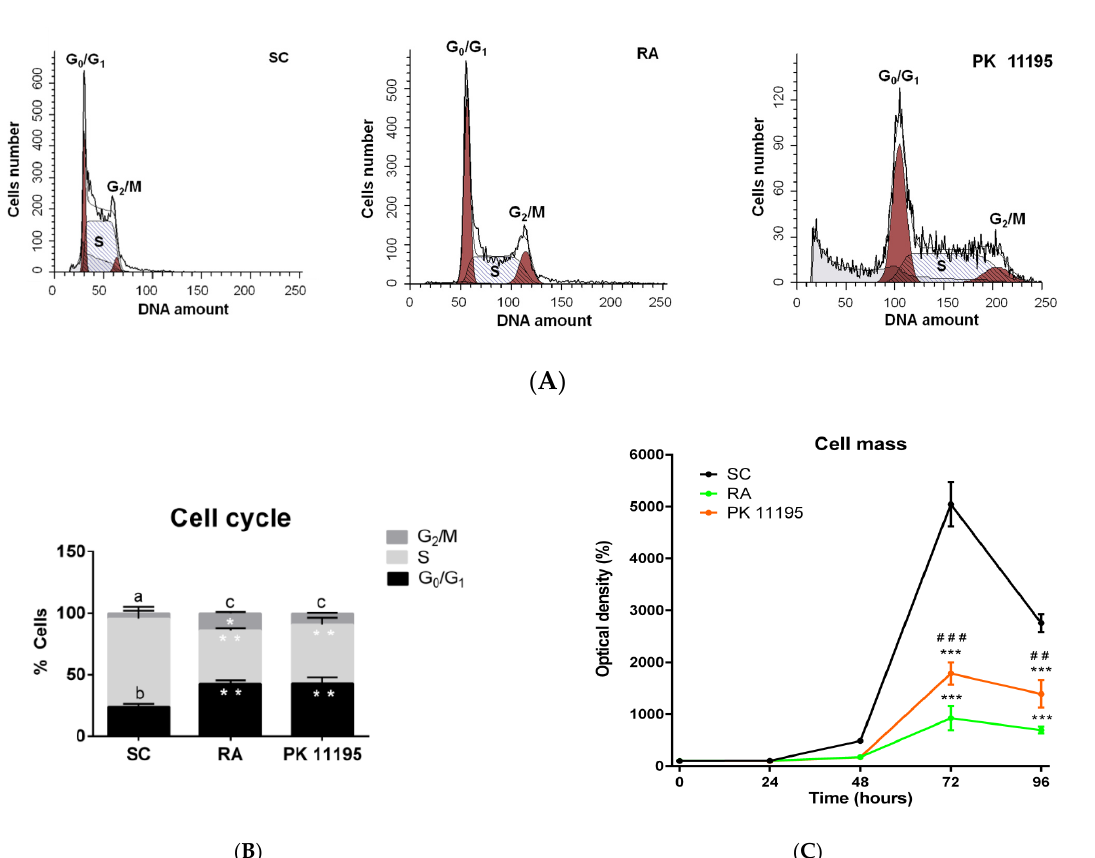
Figure 4. The cell cycle and cell mass in undifferentiated P19 stem cells (SC) and treated with 1 μ M retinoid acid (RA) or 50 μ M PK 11195 (PK 11195) during 4 days of treatment. ( A ) The cell cycle was analyzed by flow cytometry using propidium iodide. Representative histograms show relative fluorescence of DNA amount respect to cell number for each experimental condition (SC, RA and PK 11195). ( B ) Bar charts represent means ± SEM from the percentage of cells in G 1 /G 0 , S and G 2 /M phase from three independent cultures and treatments. * p < 0.05 versus SC; ** p < 0.01 versus SC; a p < 0.001 S versus G 0 /G 1 and G 2 /M in SC; b p < 0.05 G 0 /G 1 versus G 2 /M in SC.; c p < 0.001 G 2 /M versus G 0 /G 1 and S in RA and PK 1195. ( C) Cell mass was assayed by the SRB assay. Relative SRB absorbance was expressed as percentages respect to SC at 0 h. Data was expressed as means ± SEM from three independent cultures and treatments. *** p < 0.001 versus SC; # # p < 0.01 versus RA; # # # p < 0.001 versus RA.